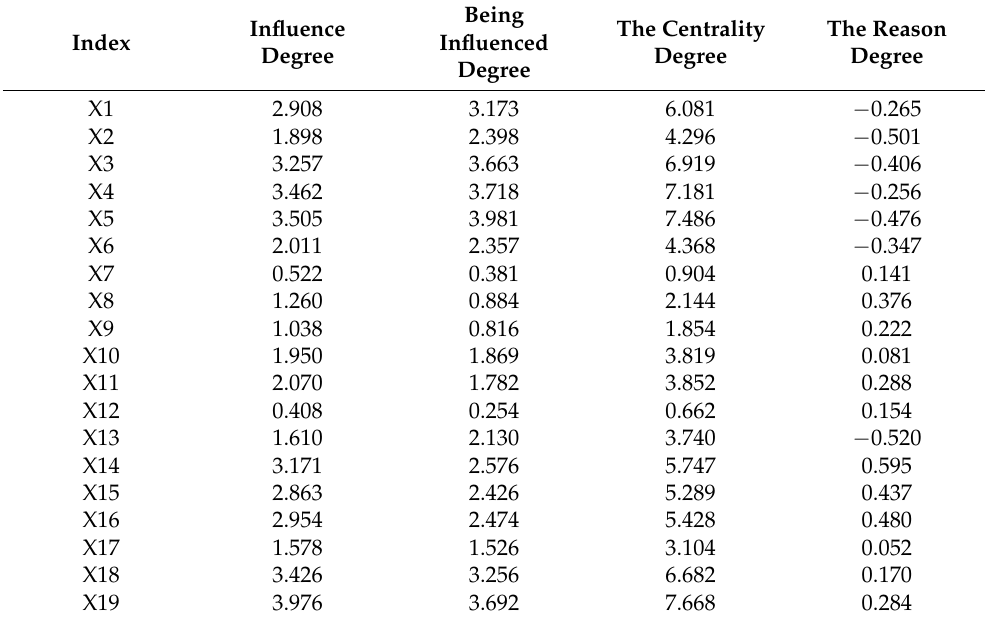
Table 3. Influence degree, being influenced degree, centrality degree, and reason